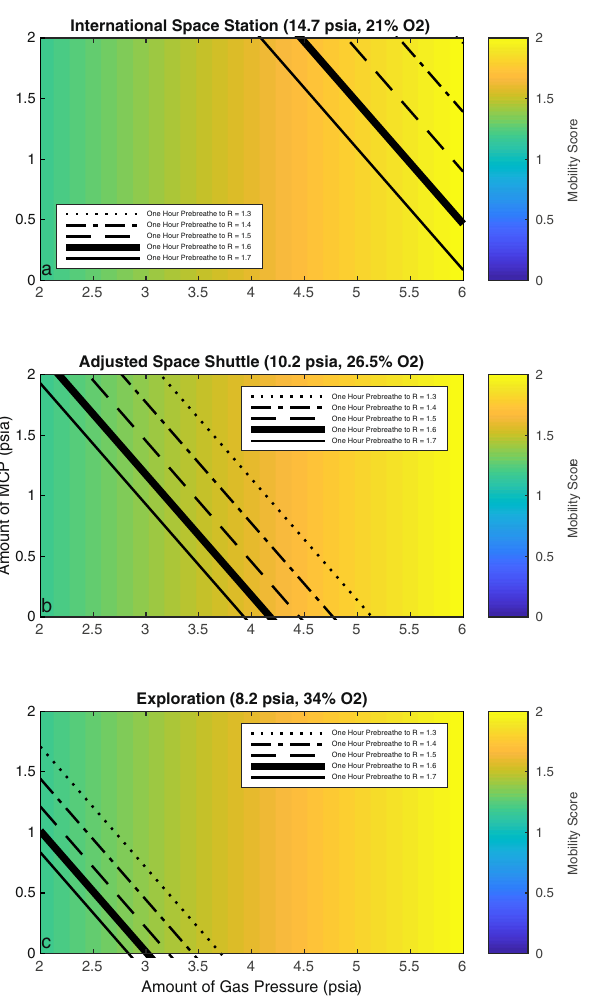
Fig. 3 Trade-off between spacesuit pressure, mobility score, and prebreathe times in ISS (top panel), adjusted Space Shuttle (middle panel), and exploration (bottom panel) atmospheric conditions. The mobility score is a function of gas spacesuit pressure (x-axis) and it is independent of the amount of pressure provided as MCP. One-hour prebreathe times for the given risk score and habitat atmospheric conditions are also indicated in the fi gures. Mobility improves (i.e., mobility score decreases) with the reduction of gas pressure. At constant prebreathe time (e.g., one hour), the risk of DCS increases with the reduction of total (gas + MCP) spacesuit pressure.